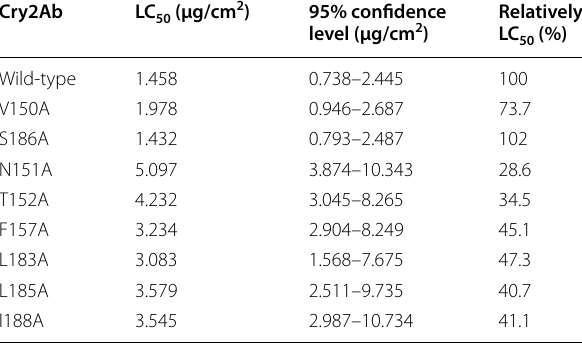
Table 1 The median lethal concentration (LC Cry2Ab and its variants against second ‐ instar larvae of